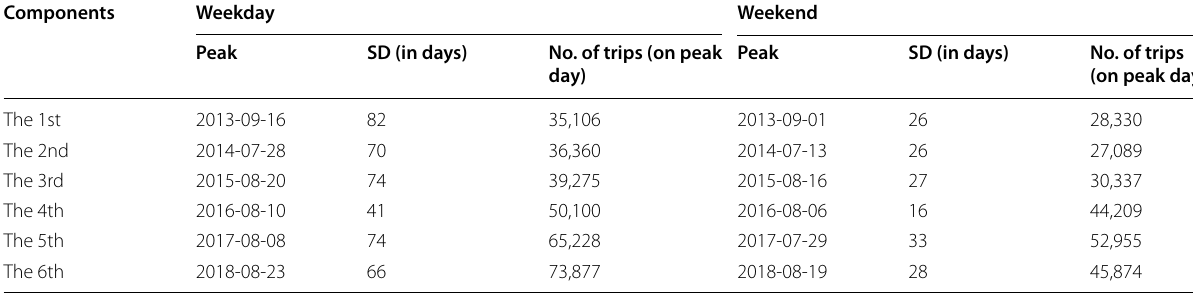
Table 3 Parameters of the mixture-of-Gaussian model